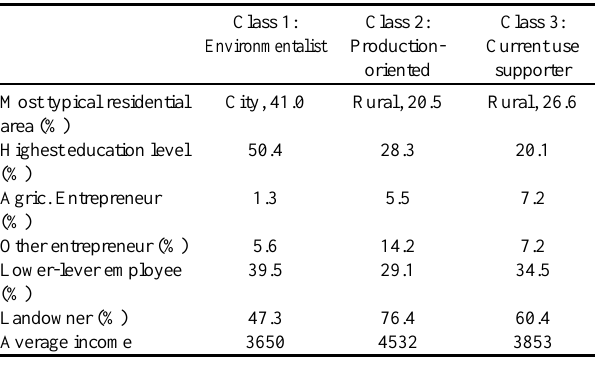
Table 3 . Percentages of respondents with specific socioeconomic characteristics in Classes 1, 2, and 3, and average household incomes (euros/month) of respondents. Number of respondents = 712.